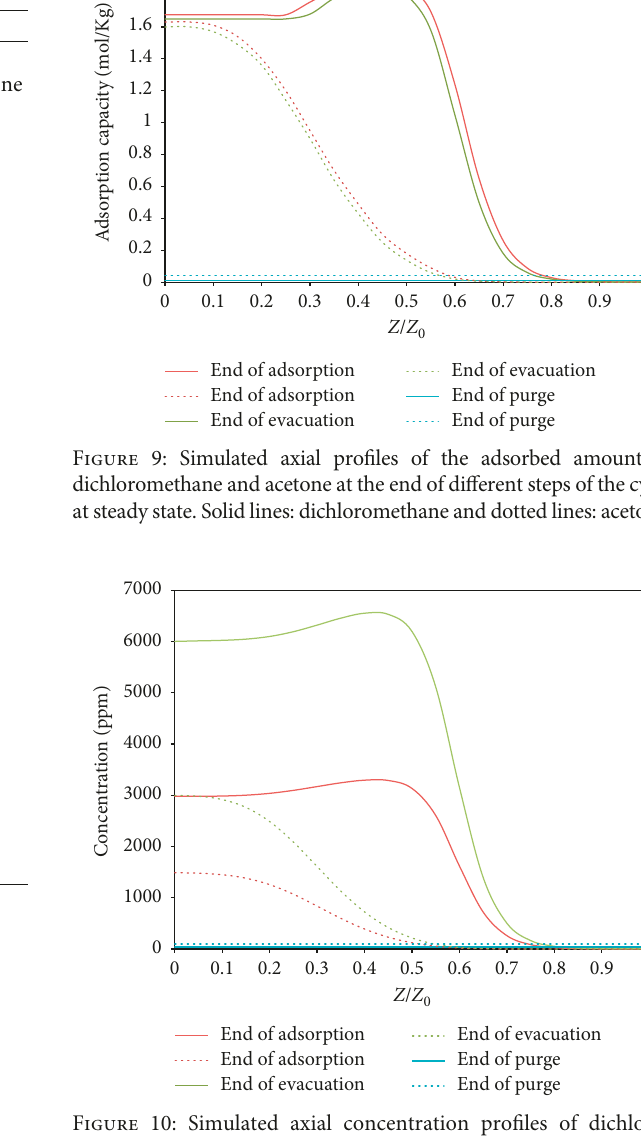
Table 3: Adsorbent and bed characteristics and operating con- ditions used in the Aspen Adsorption simulations.